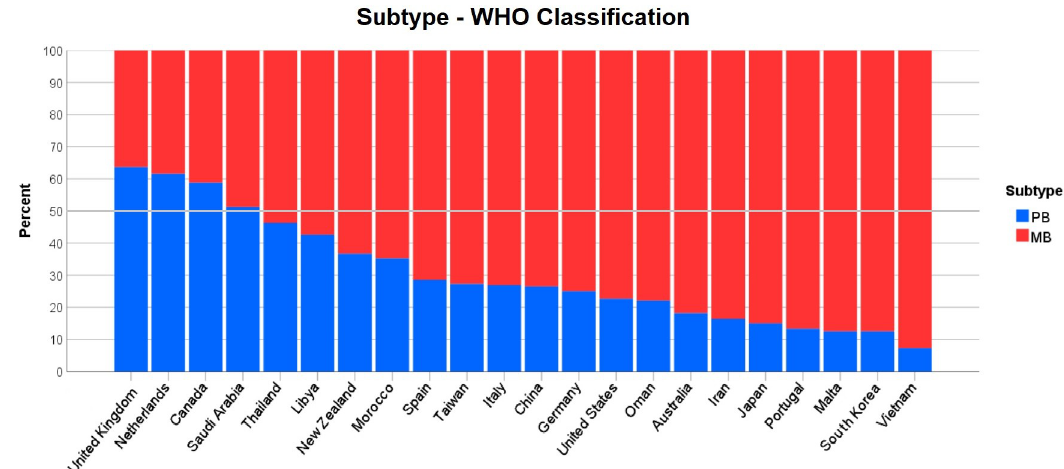
Fig 4. Leprosy subtype per country using the WHO classification system.